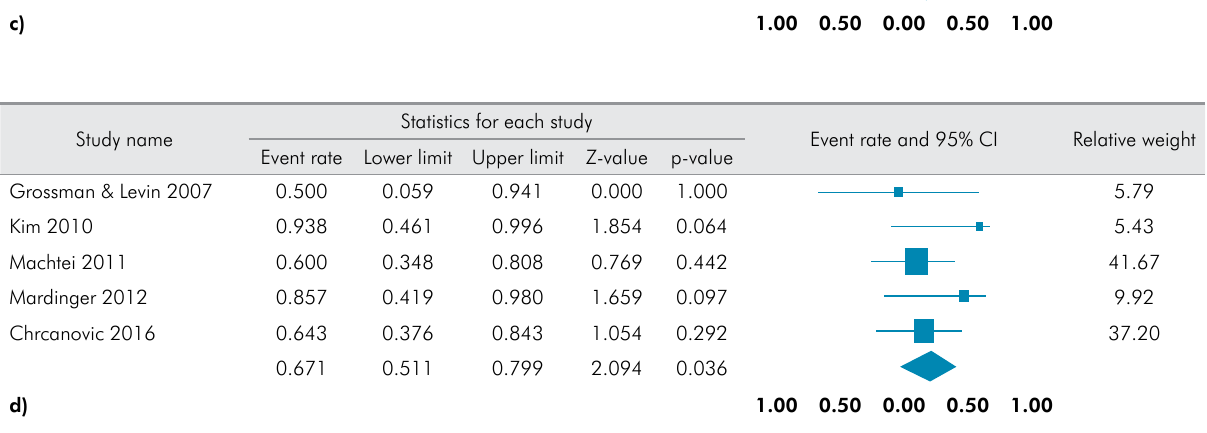
Figure 2. Survival and success rates of replacement implants. A) Weighted survival rate of implants placed at sites with history of one implant failure. B) Weighted success rate of implants placed at sites with history of one implant failure. C) Weighted survival rate of implants placed at sites with history of one early implant failure. D) Weighted survival rate of implants placed at sites with history of two implant